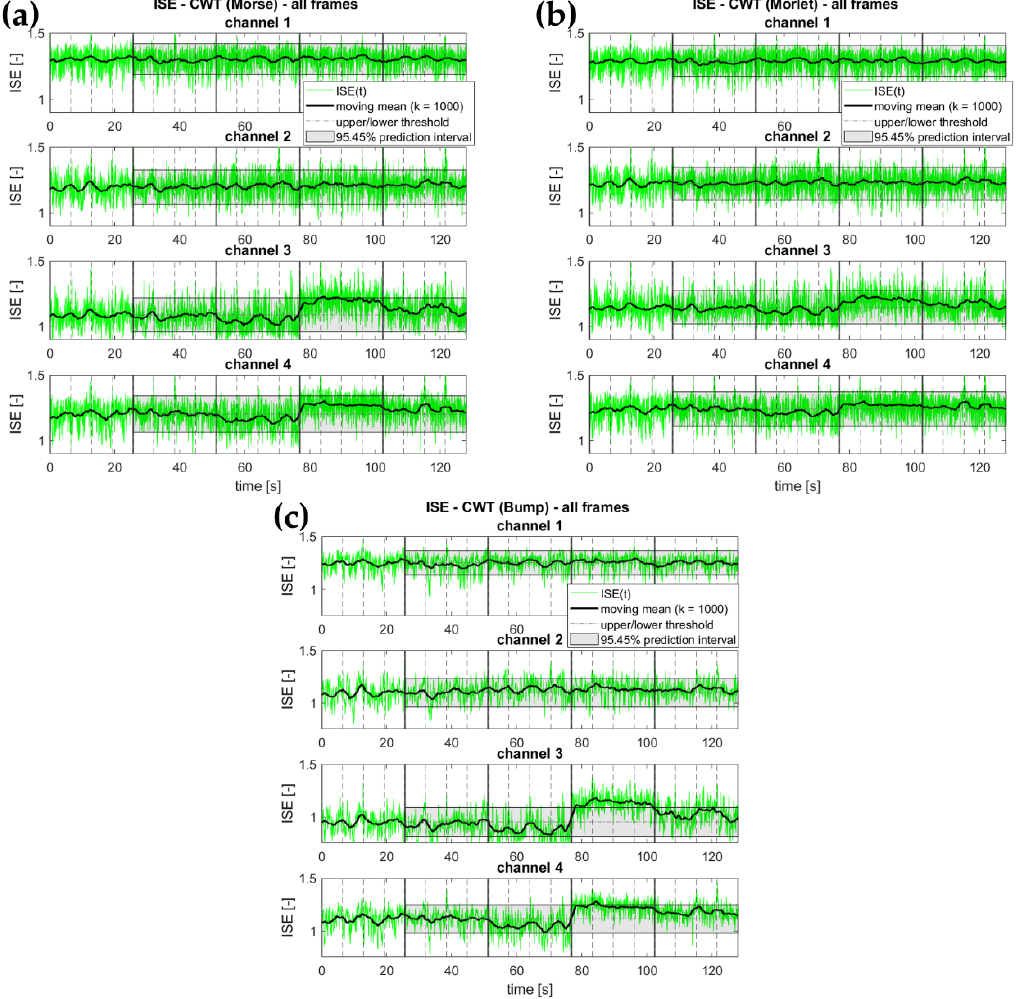
Figure 7. Results for the Rényi entropy of order 2 (collision entropy). Continuous wavelet transform with ( a ) Morse, ( b ) Morlet, and ( c ) bump wavelets.